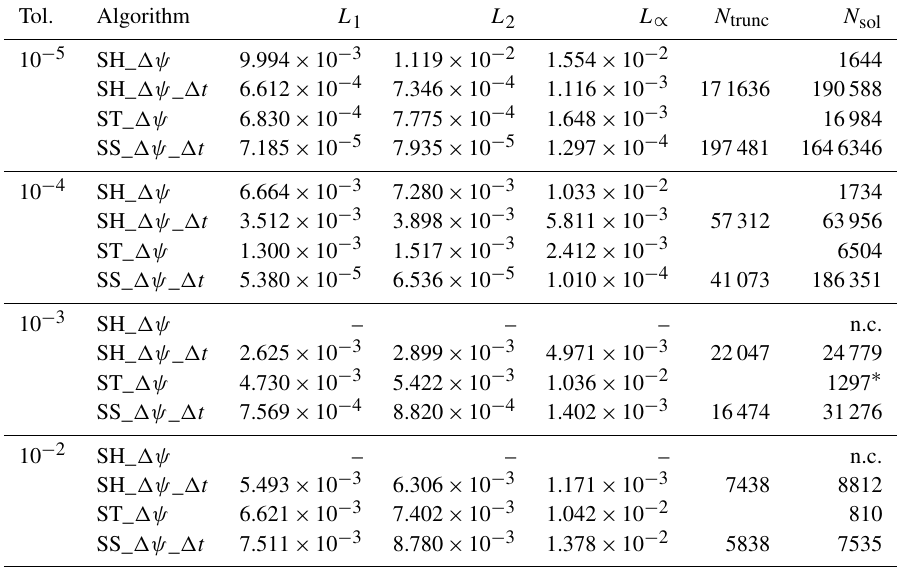
Table 7. Relative errors and number of iterations obtained for the iterative algorithm depending on different convergence criteria for TC3 (n.c.: non convergence in less than 10 7 iterations, ∗ convergence failed for 10 − 3 , τ r = 0.90 × 10 − 3 ) . Tol.